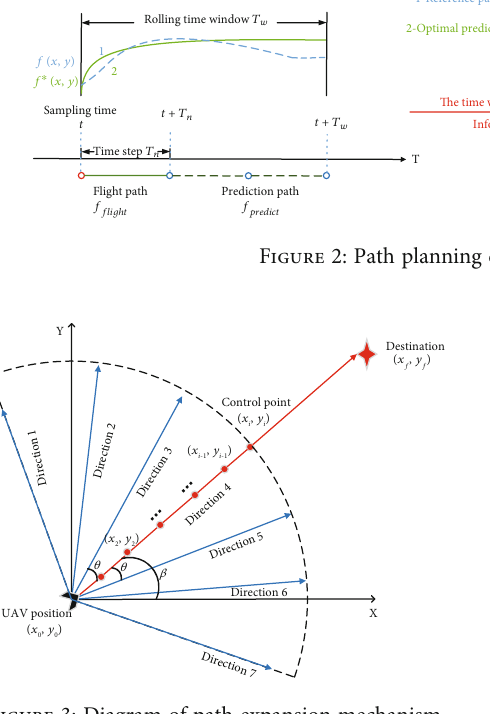
Figure 3: Diagram of path expansion